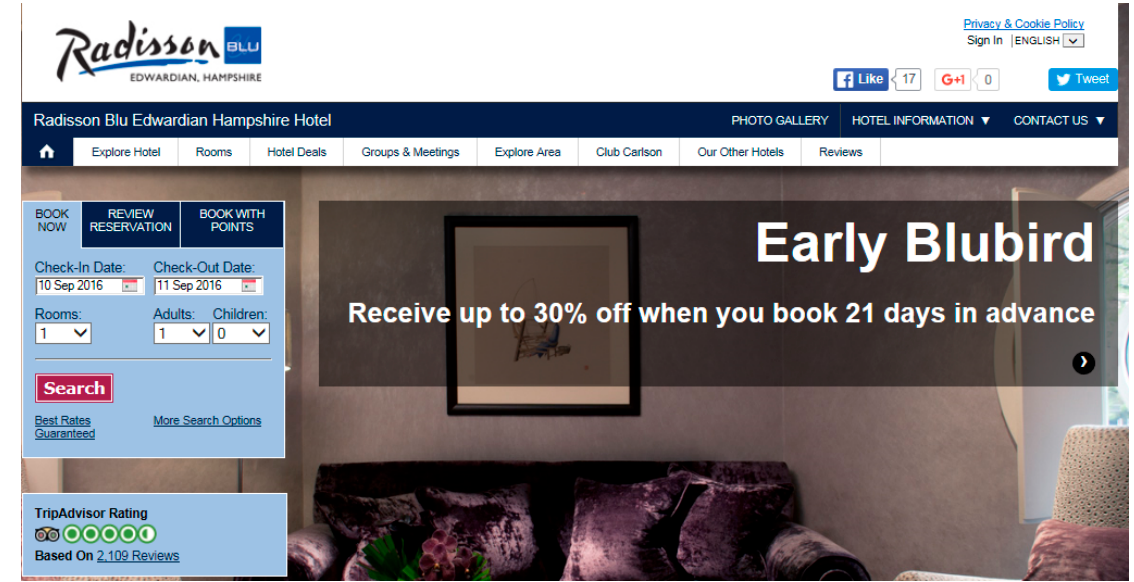
Figure A1. The rating is explicitly published on the website.